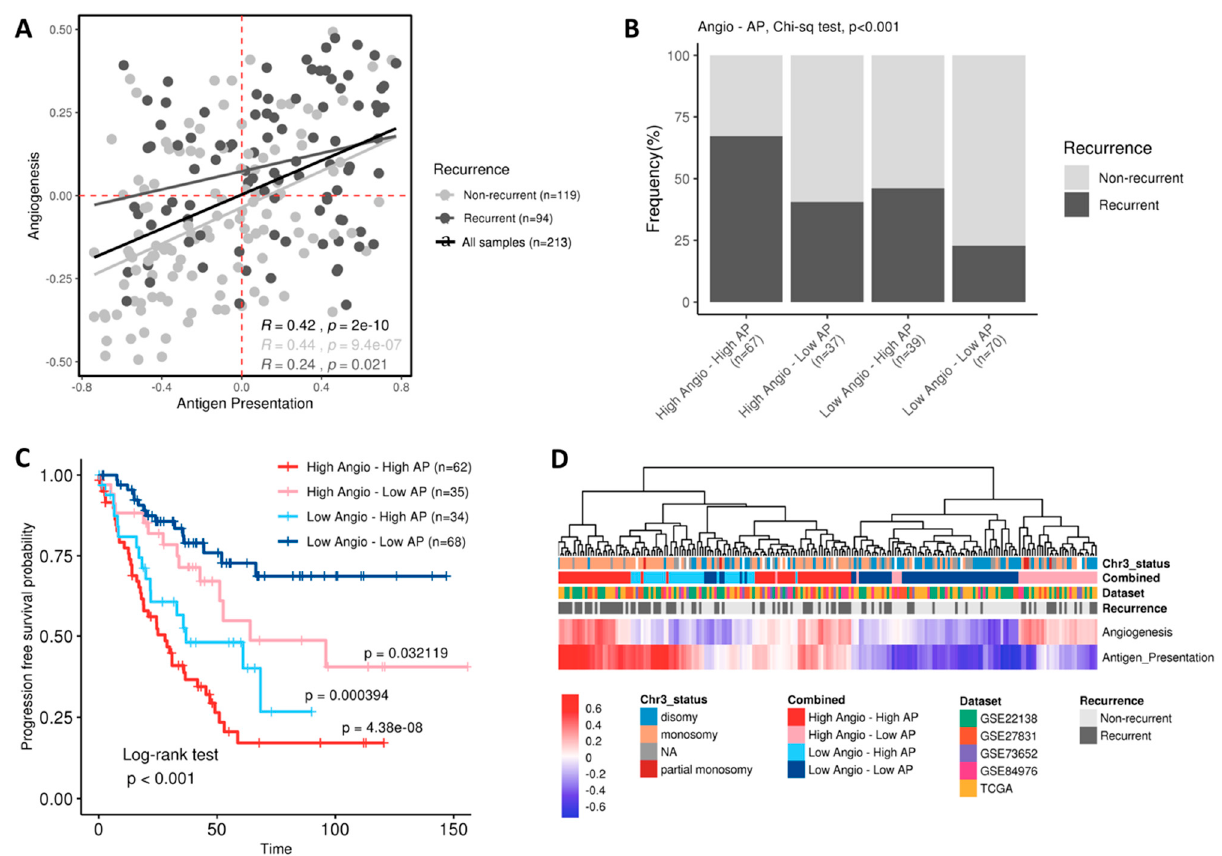
Figure 3. Combination of enrichment scores from angiogenesis (Angio) and antigen presentation (AP) signatures. ( A ) Correlation plot of Angio and AP signatures, colored by recurrent (light grey) and non-recurrent (dark grey) status. Black line represent correlation for all samples, regardless of recurrence status. The Spearman correlation was calculated and regression lines correlation scores and p -values were added for each recurrence status and for all the samples. Dashed lines indicate the cut-off used for generating the four groups. ( B ) Bar plot showing the frequency of recurrent samples in the different groups of Angio-AP combinations. ( C ) Kaplan–Meier survival curves of the four groups from combination of Angio and AP scores. Log-rank p -value is indicated. Cox proportional hazard ratios test between the Low Angio-Low AP reference group and the other three groups was calculated, and p -values are also indicated. ( D ) Hierarchical clustering of all UM samples ( n = 213) using the Angio and AP scores. Bars on top represent chromosome 3 status, dataset, recurrence and combined score.